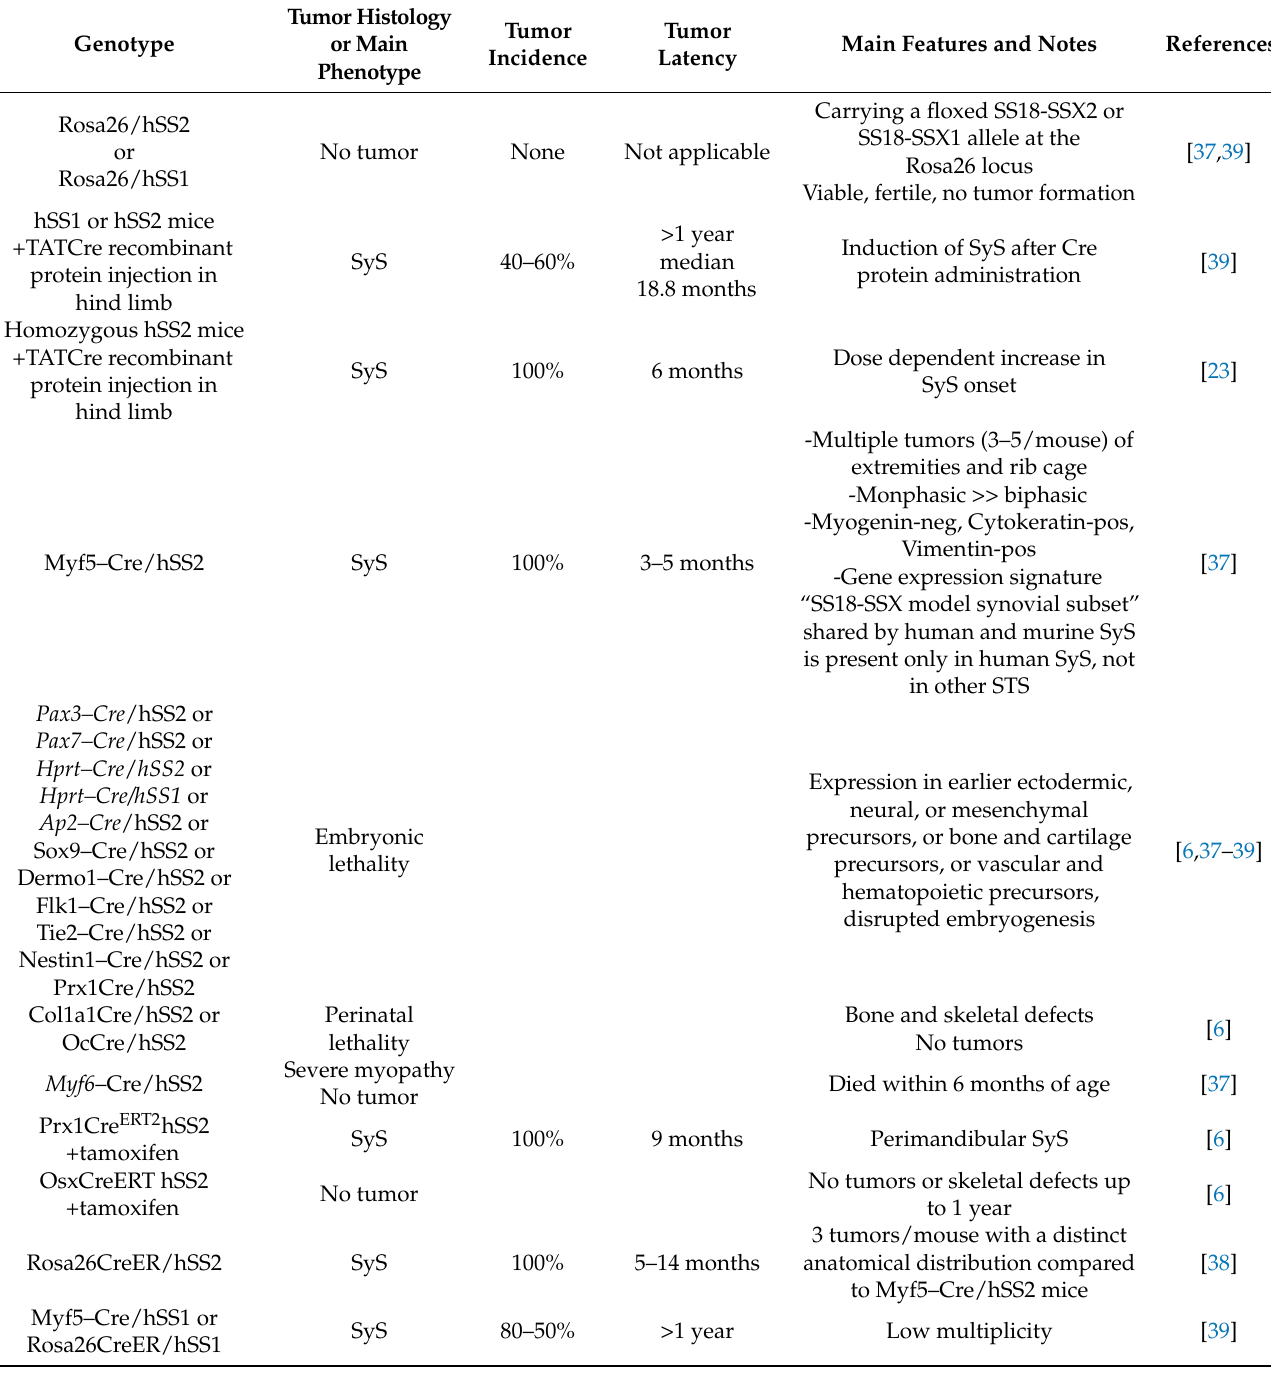
Table 1. SyS conditional genetically engineered mouse